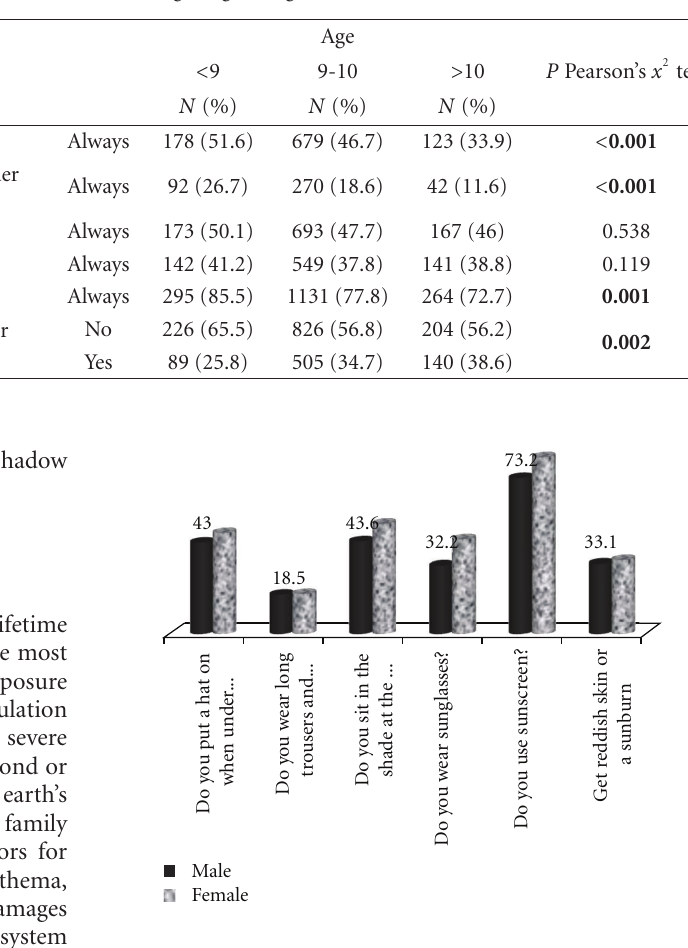
Table 3: Students’ behaviour according to age and gender.